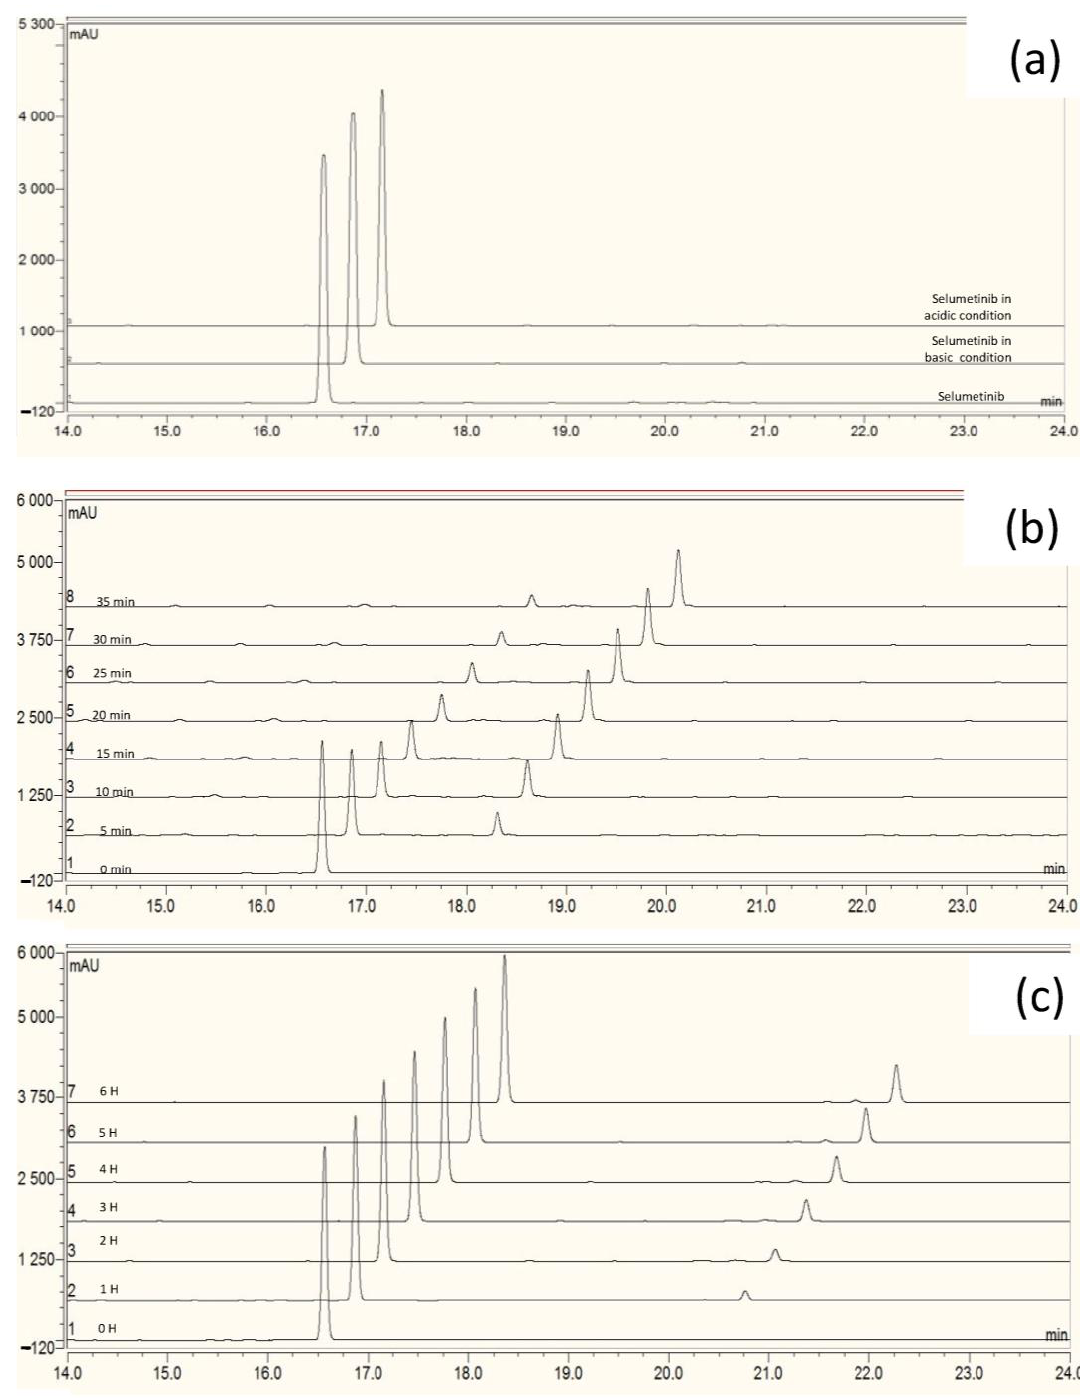
Figure 1. Inset ( a ): chromatograms of freshly prepared selumetinib solution (black plot), selumetinib solution exposed to acidic conditions for one week (blue plot) and selumetinib solution exposed to basic conditions for one week. Inset ( b ): chromatograms of selumetinib solution exposed to light irradiation obtained after analysis of samples taken every 5 min for 35 min. Inset ( c ): chromatograms of selumetinib solution exposed to oxidative stress (3% H 2 O 2 , 40 °C) obtained after the analysis of samples taken every hour for at least 5 h.